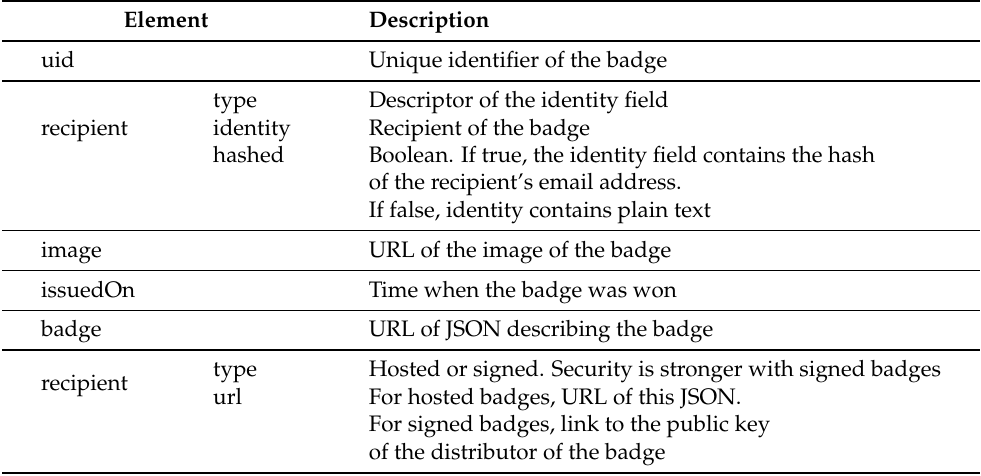
Table A1. JSON structure describing possession of a badge.